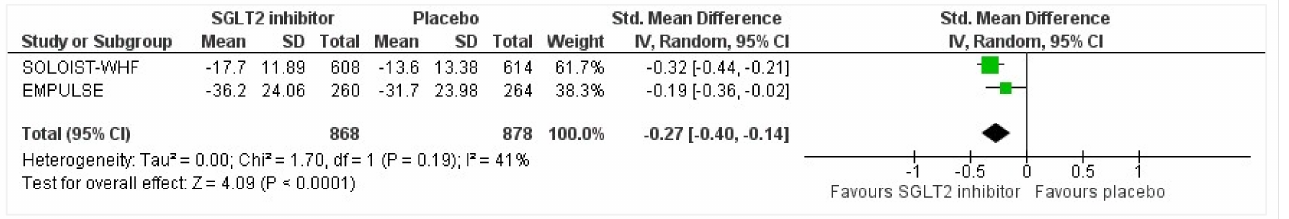
Figure 6. Forest plot for the adjusted mean change in KCCQ-TSS (mean values [SD]) at 90 days from baseline in either group [25,27].